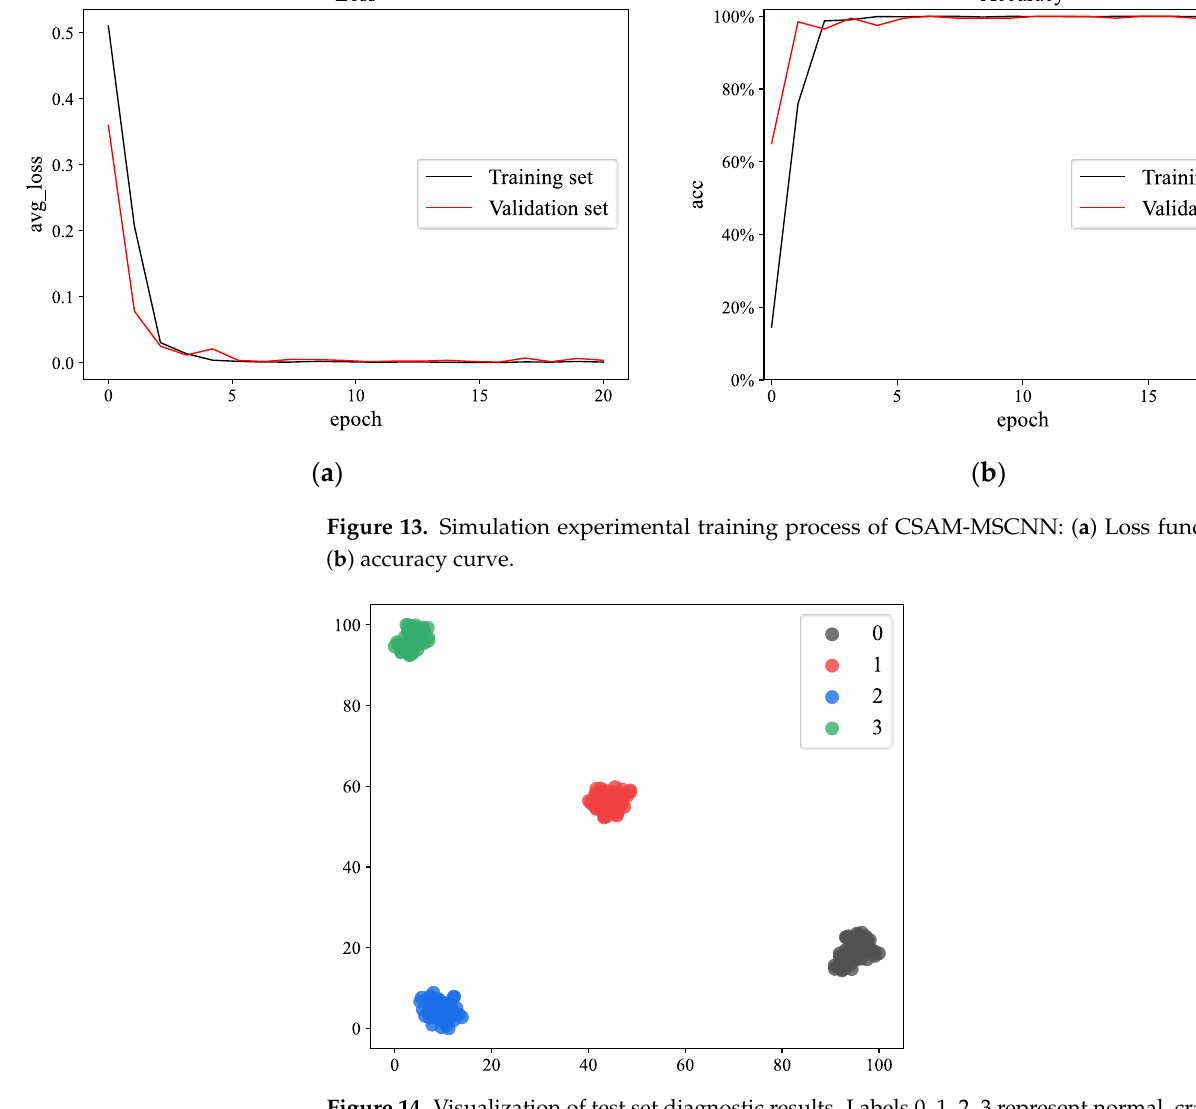
Figure 14. Visualization of test set diagnostic results. Labels 0, 1, 2, 3 represent normal, cracked tooth, pitting tooth, and gear crack-pitting compound failure, respectively.